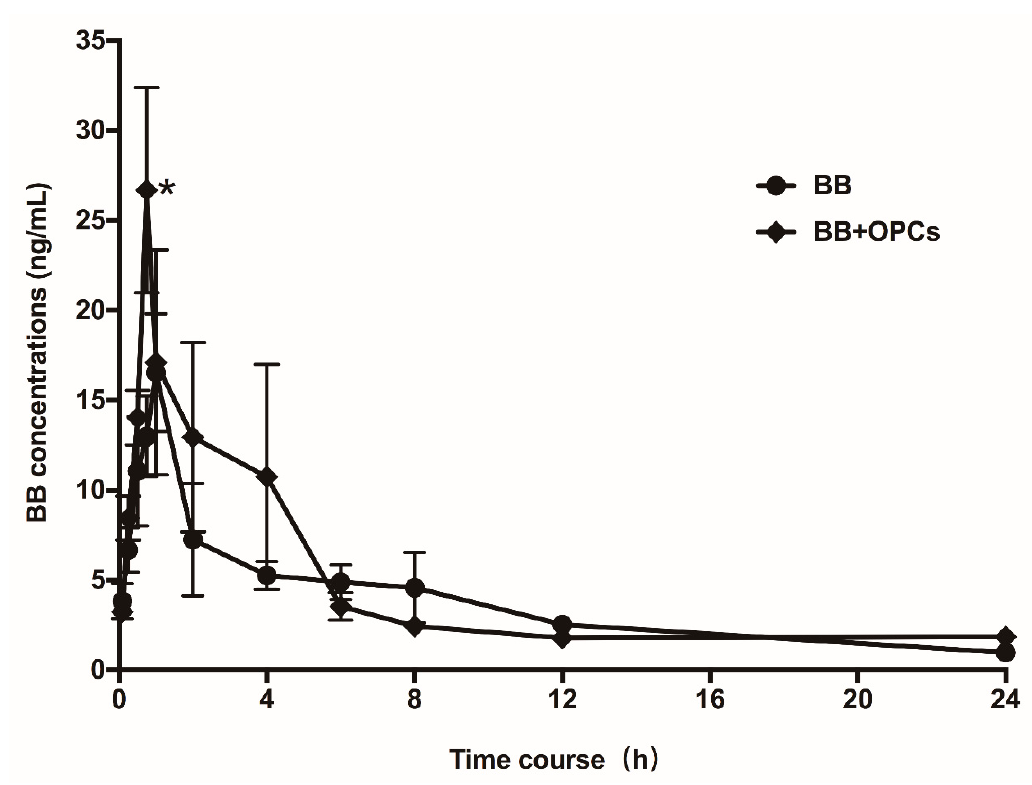
Figure 9. Pharmacokinetic Study. Male SD mice were orally administered with BB alone at 200 mg/kg, or 200 mg/kg of BB plus 120 mg/kg of OPCs, respectively. Blood samples were taken at 0, 0.083, 0.25, 0.5, 0.75, 1, 2, 4, 6, 8, 12, and 24 h after administration. Plasma concentrations of BB were determined by LC–MS/MS and plotted against time. Data are presented as mean ± SEM of six animals in each group. * p < 0.05 vs. that of the same time point.